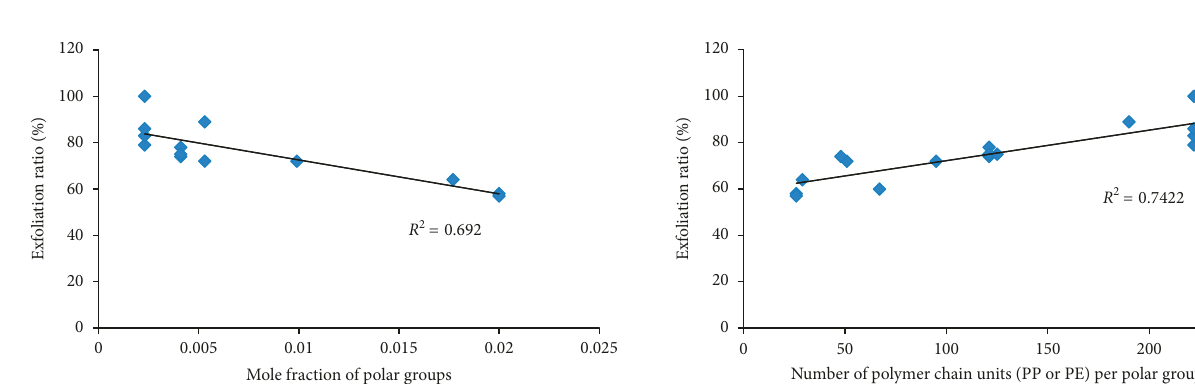
Figure 2: Nanoclay exfoliation ratio as a function of the mole fraction of polar groups in the compatibilizer.